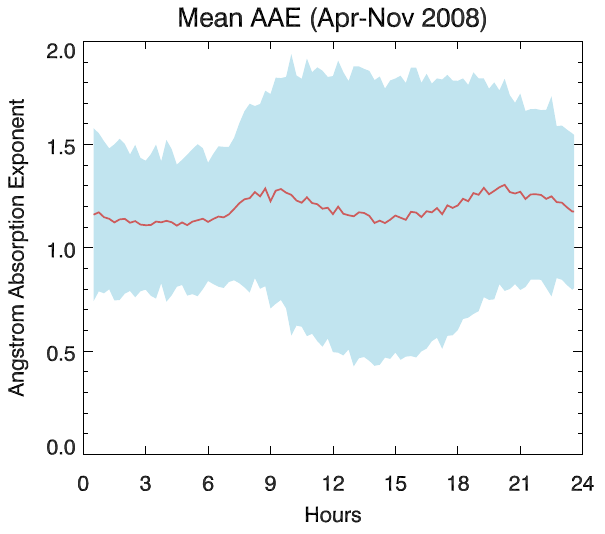
Fig. 6. Diurnal variation of angstrom absorption exponent (AAE).